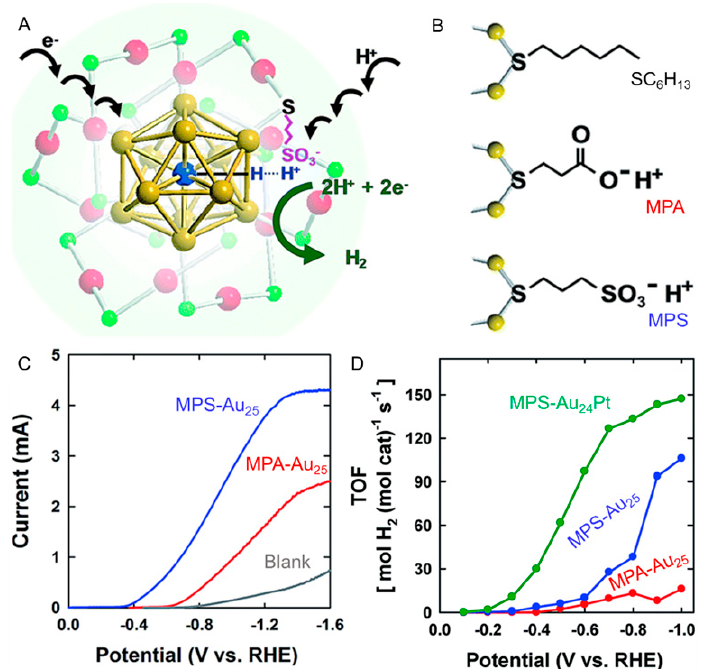
Figure 4. ( A ) Schematic illustration of proton relay mechanism of Au 24 Pt(SR) 18 nanocluster for formation of H 2 and ( B ) ligand structures: SC 6 H 13 , MPA, and MPS. Color codes: blue = Pt; golden = core Au; red = shell Au; and green = S. ( C ) HER polarization curves in 0.1 M KCl aqueous solution containing 180 mM acetic acid for MPA-Au 25 (red) or MPS-Au 25 (blue). ( D ) turnover frequencies (TOFs) obtained at various potentials in water (3.0 M KCl) containing 180 mM HOAc for MPA-Au 25 (red), MPS-Au 25 (blue), or MPS-Au 24 Pt (green). Panels ( A – D ) are reproduced with permission from reference [109]. Copyright Royal Society of Chemistry,